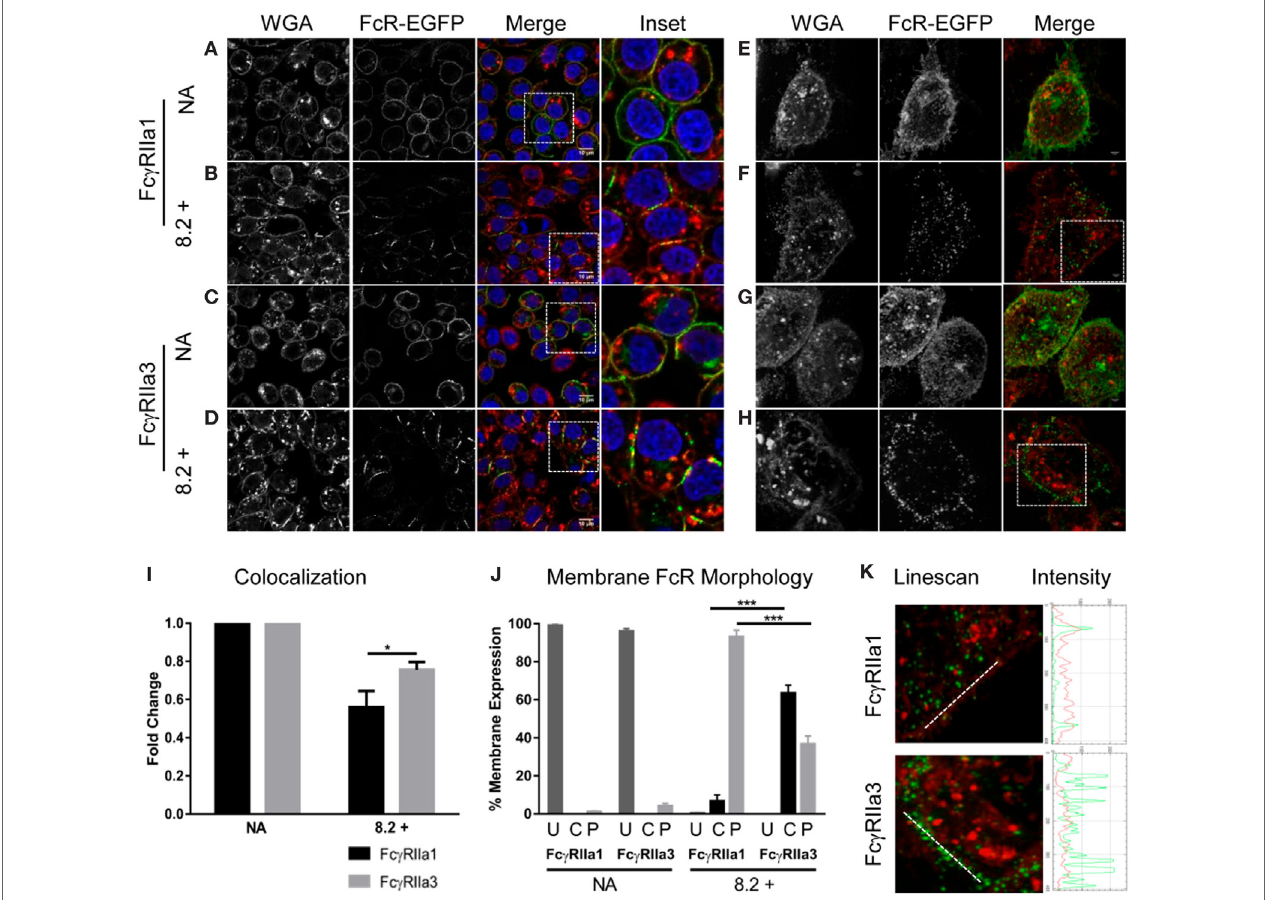
FigUre 4 | Receptor distribution following stimulation. Panels (a–D) are focal plane confocal images of z -series (scale bars 10 µm) and panels (e–h) are representative 3D maximum intensity projection of N-SIM super resolution images (scale bars 5 µm) of RBL cells expressing Fc γ RIIa1–EGFP or Fc γ RIIa3–EGFP (green). Cells were untreated (no addition/NA) [panels (a,c,e,g) ] or stimulated with mAb 8.2 (30 µg/mL) for 5 min at 37°C [panels (B,D,F,h) ]. The plasma membrane was stained using wheat germ agglutinin (WGA) AlexaFluor-633 (red) and the nucleus stained using Hoechst 33258 (blue). Cells were imaged in PBS at room temperature using a Nikon A1 + -SI laser scanning confocal or N-SIM microscope and analyzed using the open source Java application ImageJ (see Materials and Methods). Panel (i) shows Pearson’s correlation coefficient ( r ) calculated for Fc γ R and WGA colocalization and normalized for resting state (NA) to represent the fold change in membrane and receptor colocalization ( n = 3, 10 z-stacks per experiment). Panel (J) shows proportion of cells displaying cap or punctate membrane structures determined by blind-counting 100 cells prior to addition (NA) or following 5 min stimulation with mAb 8.2 (mean ± SEM, n = 3, 100 cells counted per experiment). Receptor distribution was defined as U = uniform, C = condensed caps, P = punctate morphology (defined in Figure S2 in Supplementary Material). Panel (K) Linescan, profiles across membrane segments from stimulated cells as in (panel F and G above). Linescan shown by white line in (left) panels and the corresponding intensity profiles of Fc γ R (green) and plasma membrane (red)